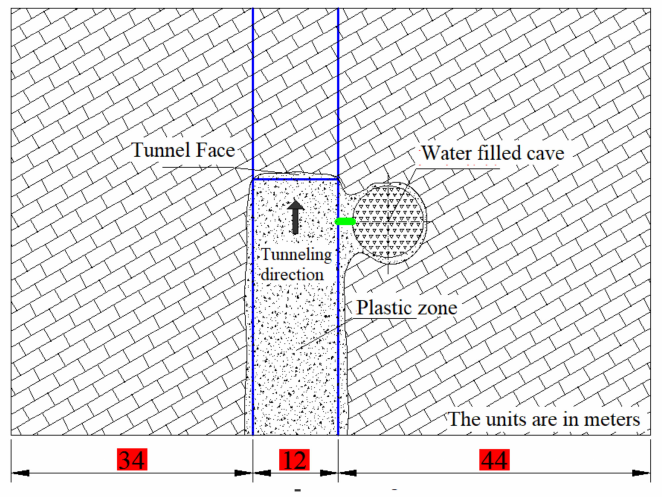
Figure 7. Schematic diagram of the surrounding rock of the tunnel and the penetration of the plastic zone.